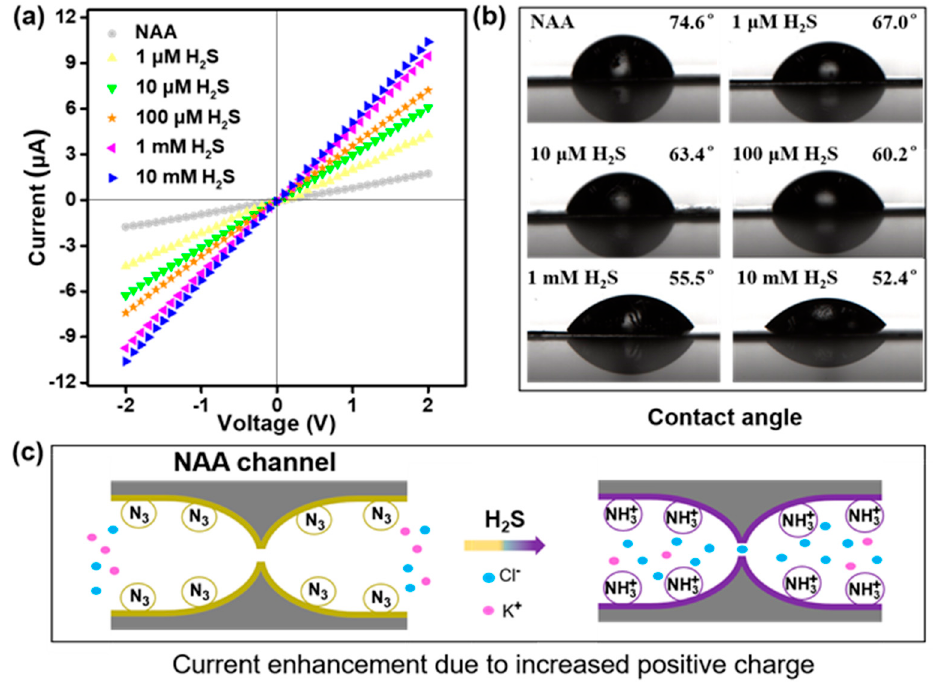
Figure 2. Electrical signal response on H 2 S of functionalized NAA–modified nanochannels. ( a ) I-V curves of the nanochannel membrane upon incremental H 2 S concentration in 1 mM KCl. ( b ) The evolution for wettability of the nanochannel membrane upon incremental H 2 S concentration via CA measurement. ( c ) The schematic diagram of the mechanism of transmembrane current increase upon H 2 S exposure.